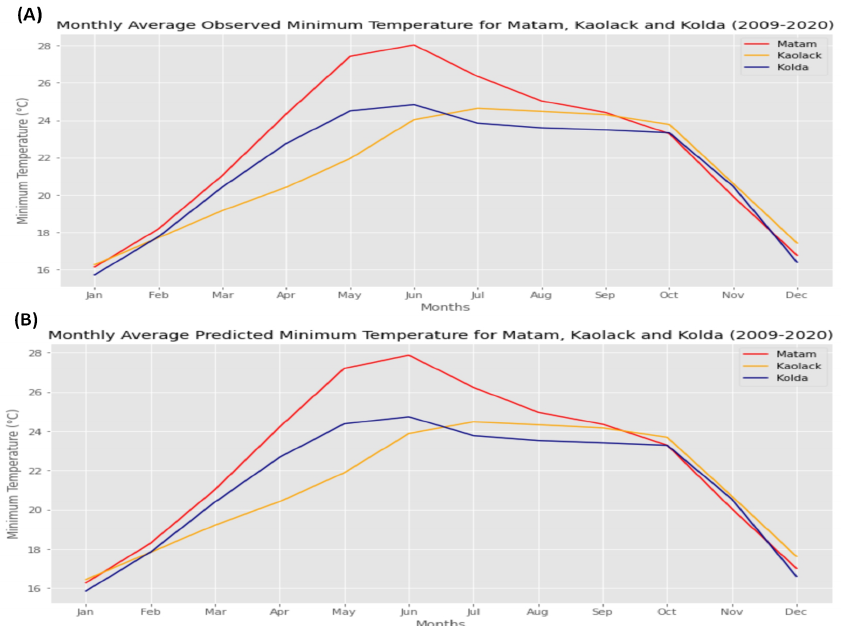
Figure 26. Monthly Average Observed and Forecasted Minimum Temperature for Matam, Kaolack and Kolda